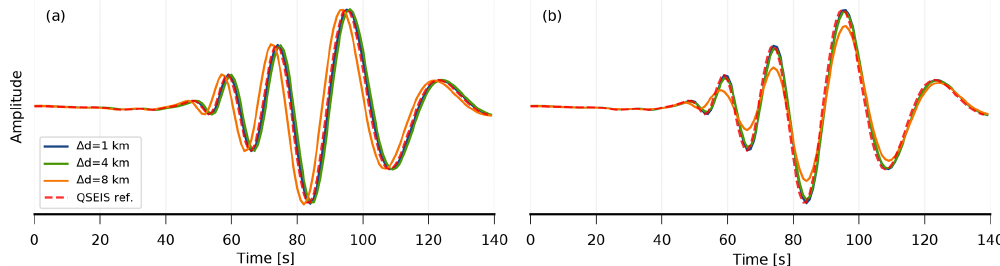
Figure 3. Comparison of interpolation artefacts on synthetic waveforms with different GF grid spacings ( a : nearest neighbour, b : multi- linear). Shown are vertical component displacements based on GF stores with 1, 4, and 8km spatial grid spacing (blue, green, and orange, respectively) against a reference for the exact source–receiver distance (QSEIS; red). The sampling rate is 2Hz and the signal contains information up to close to the Nyquist frequency (1Hz). The waveforms are filtered with a pass band from 0.05 to 0.1Hz after interpolation. The medium is layered with important discontinuities of upper crust, lower crust, and mantle at 20 and 35km of depth. The slowest seismic velocity in the medium is 3.5kms − 1 . The waveform is simulated for a 10km deep moment tensor source at a distance of